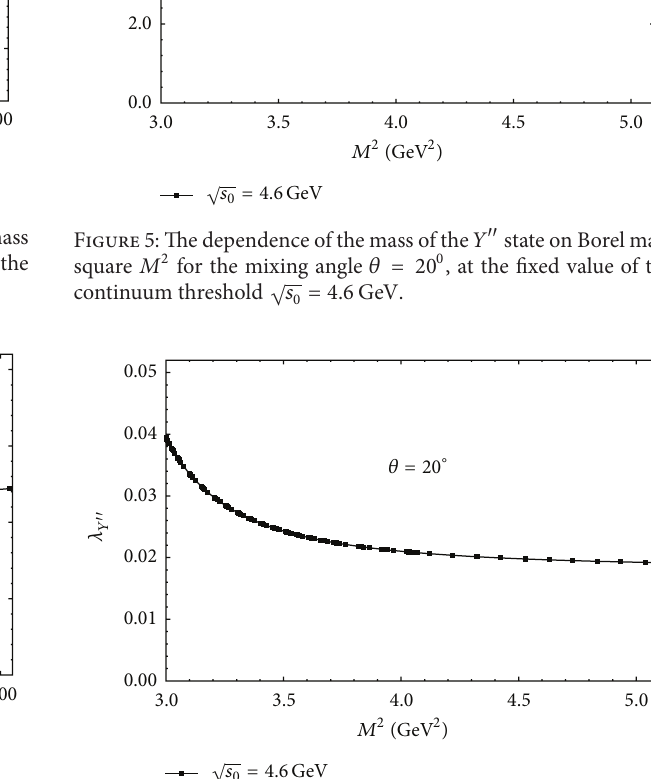
Figure 6: The dependence of the residue of the 𝑌 󸀠󸀠 state on Borel mass square 𝑀 2 for the mixing angle 𝜃 = 20 0 , at the fixed value of the continuum threshold √𝑠 0 = 4.6